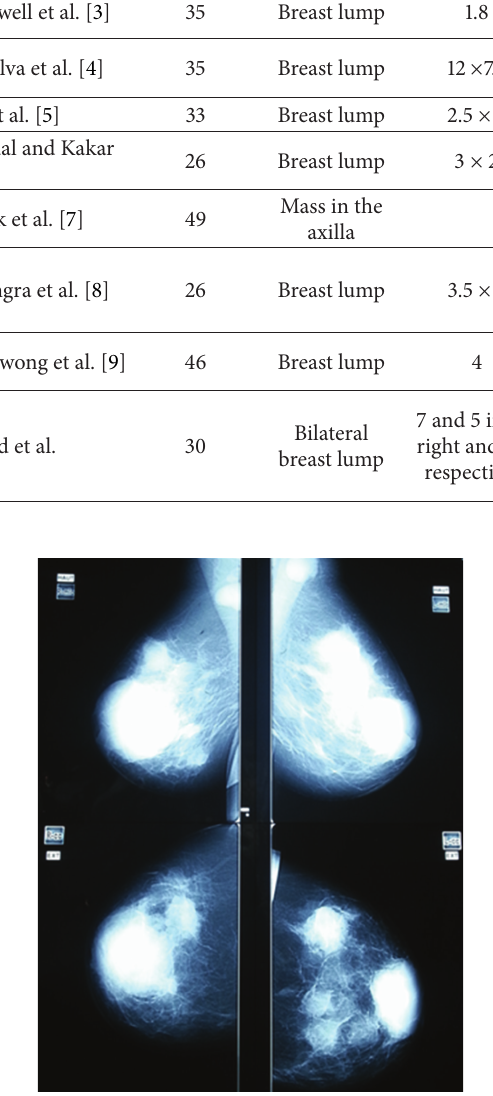
Figure 1: The mediolateral oblique (MLO) and craniocaudal (CC) view of the left and right breast